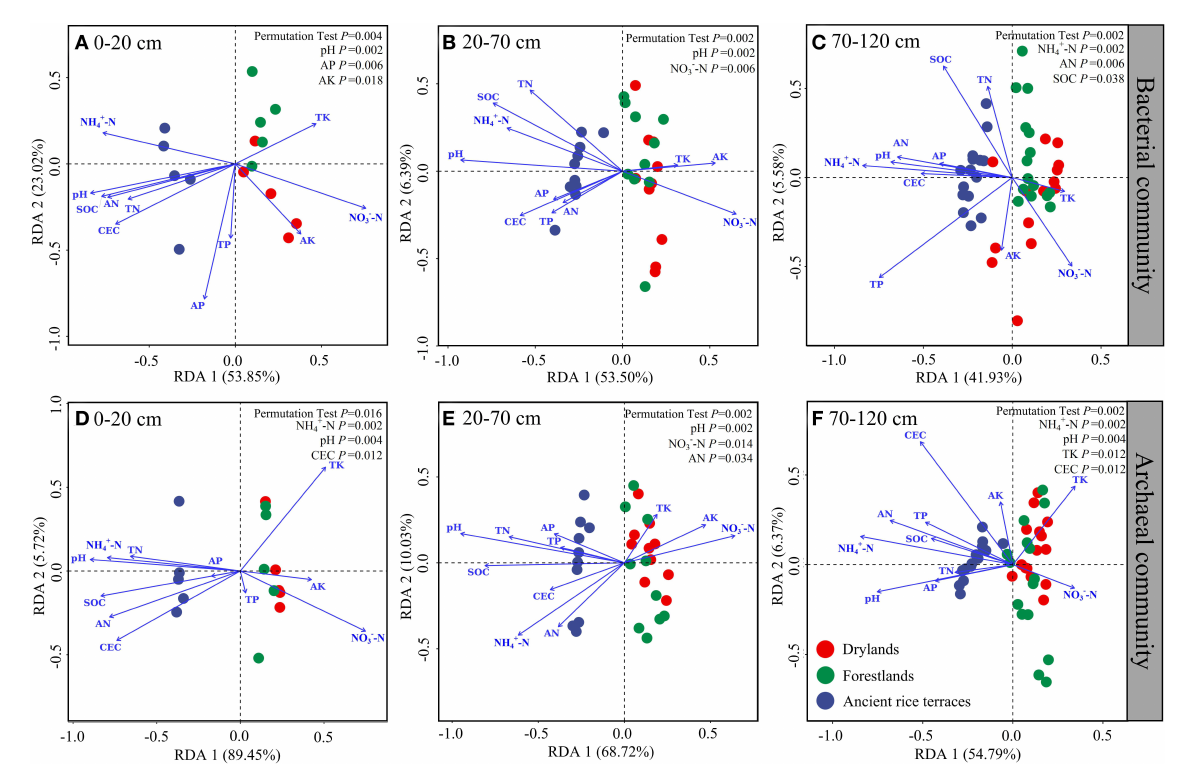
FIGURE6 (A–F) Redundancy analysis of soil properties and prokaryotic communities in different soil